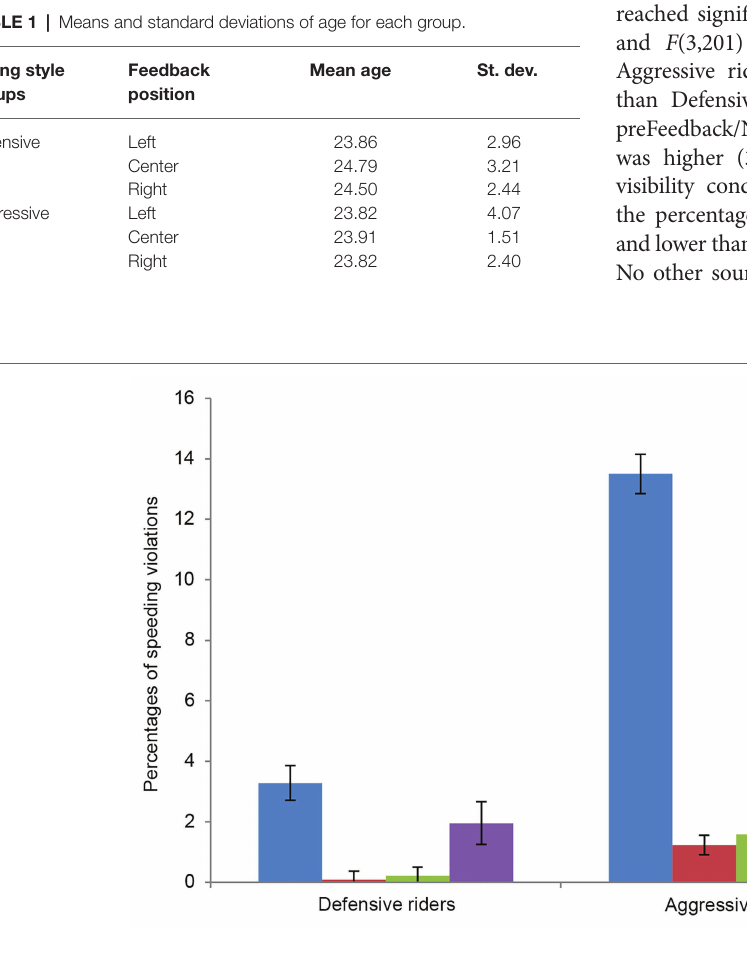
FIGURE 3 | Percentage of speeding violations (over the limits indicated by traffic signals) of Defensive and Aggressive riders in the four visibility conditions. Vertical bars represent standard